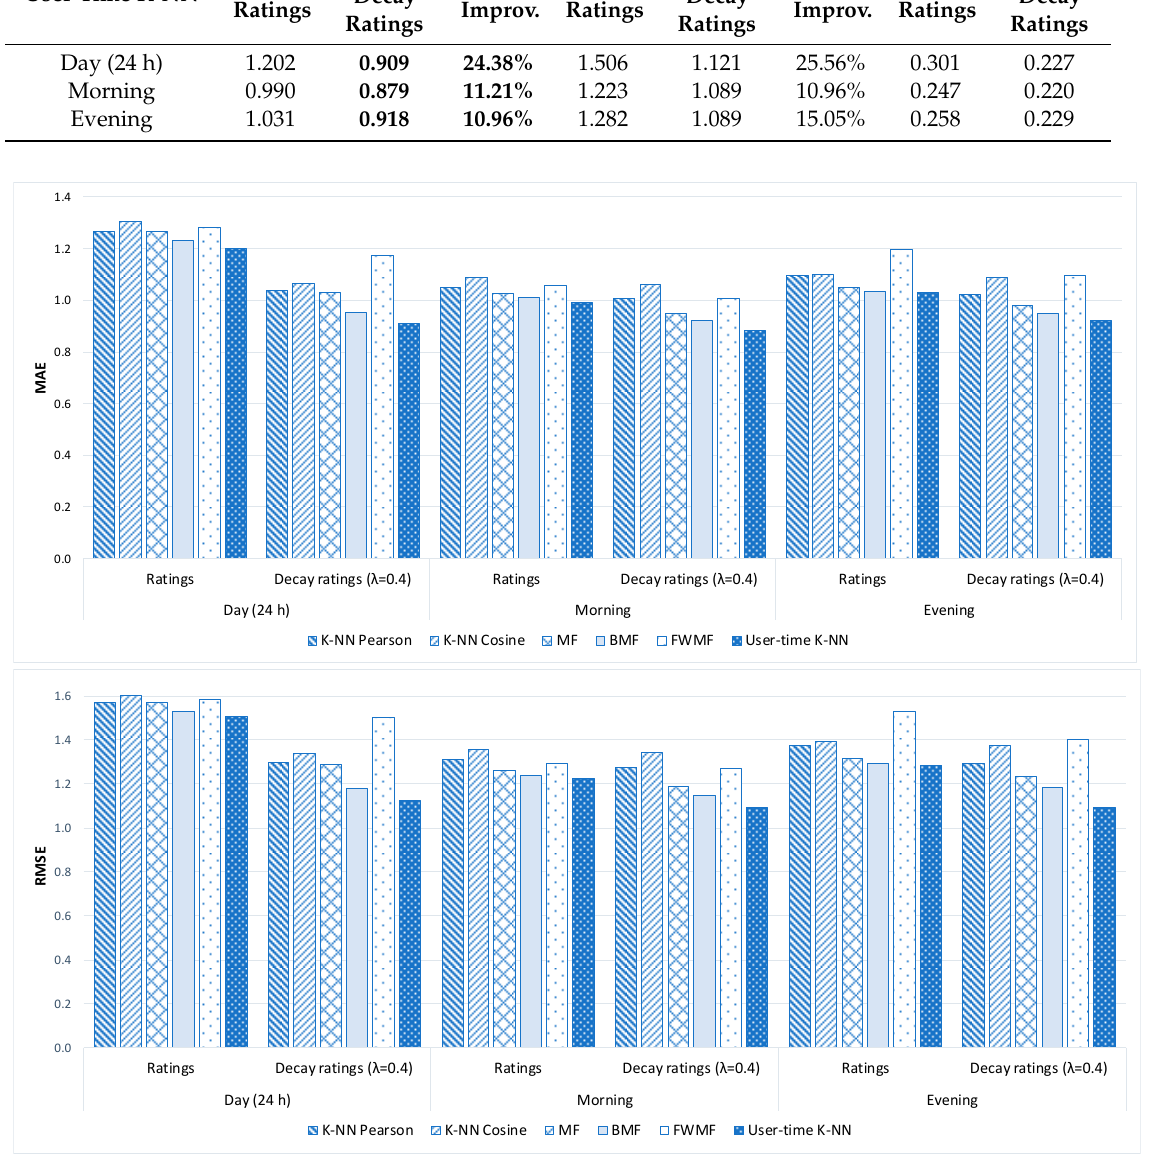
Figure 7. The MAE and RMSE values obtained using the time of day as an additional attribute in collaborative filtering (CF (user-time K-NN)) versus the simple use of ratings or decay ratings.